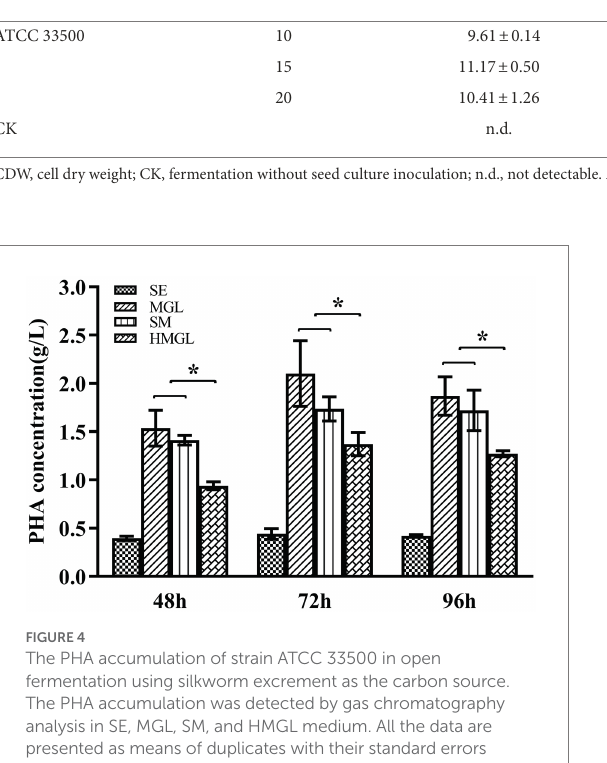
TABLE 3 Determination of the PHA accumulation under different NaCl concentration. Strains